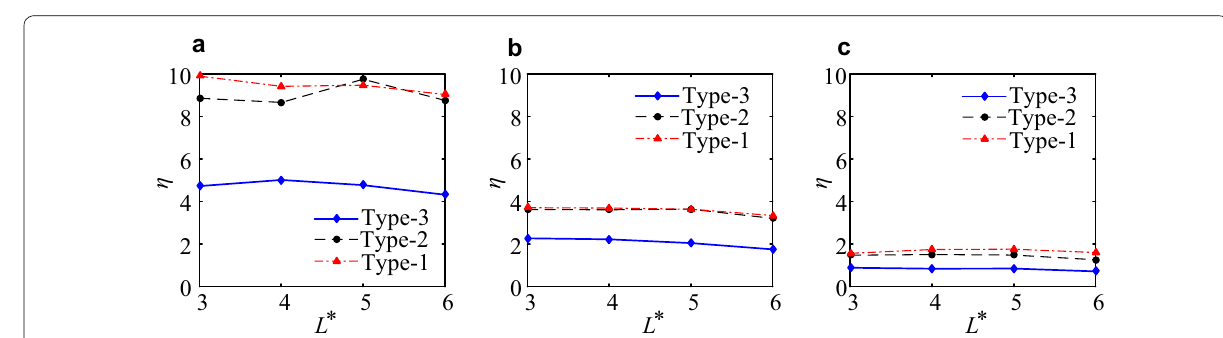
Fig. 7 Pressure drop of three types of PBRs with different L *. L * represents the PBR without ribs, i.e., the smooth PBR, which serves as a benchmark here